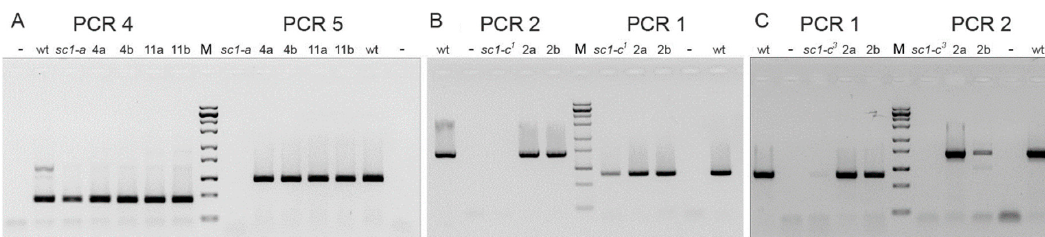
Figure 6. Inheritance of the deletions inferred in screwy mutants. ( A ) Results of PCRs for the cross sc1-a x wt (wild type strain 51). 4a, 4b, 11a, 11b are pairs of exconjugant F1 clones from the cross. Both PCR4 primers are present in the mutant genome, while downstream primer of PCR5 is absent. ( B ) Results of PCRs for the cross sc1-c 1 x wt. 2a, 2b are a pair of exconjugant F1 clones from the cross. ( C ) Results of PCRs for the cross sc1-c 3 x wt. 2a, 2b are a pair of exconjugant F1 clones from the cross. For ( B , C ) both PCR1 primers are present in the mutant genome, while downstream primer of PCR2 is absent. M is ZipRuler ™ Express DNA Ladder Set (Thermo Fisher, USA); “–” stands for negative control. The PCRs show that the sequence deleted in the mutant parent is always present in both heterozygous F1s (from both cytoplasmic lineages) obtained in a cross of the mutant to the wild-type parent. Thus, deletions in mutant’ sc1 loci are not inherited maternally, which allows to suggest that they occur in MICs.